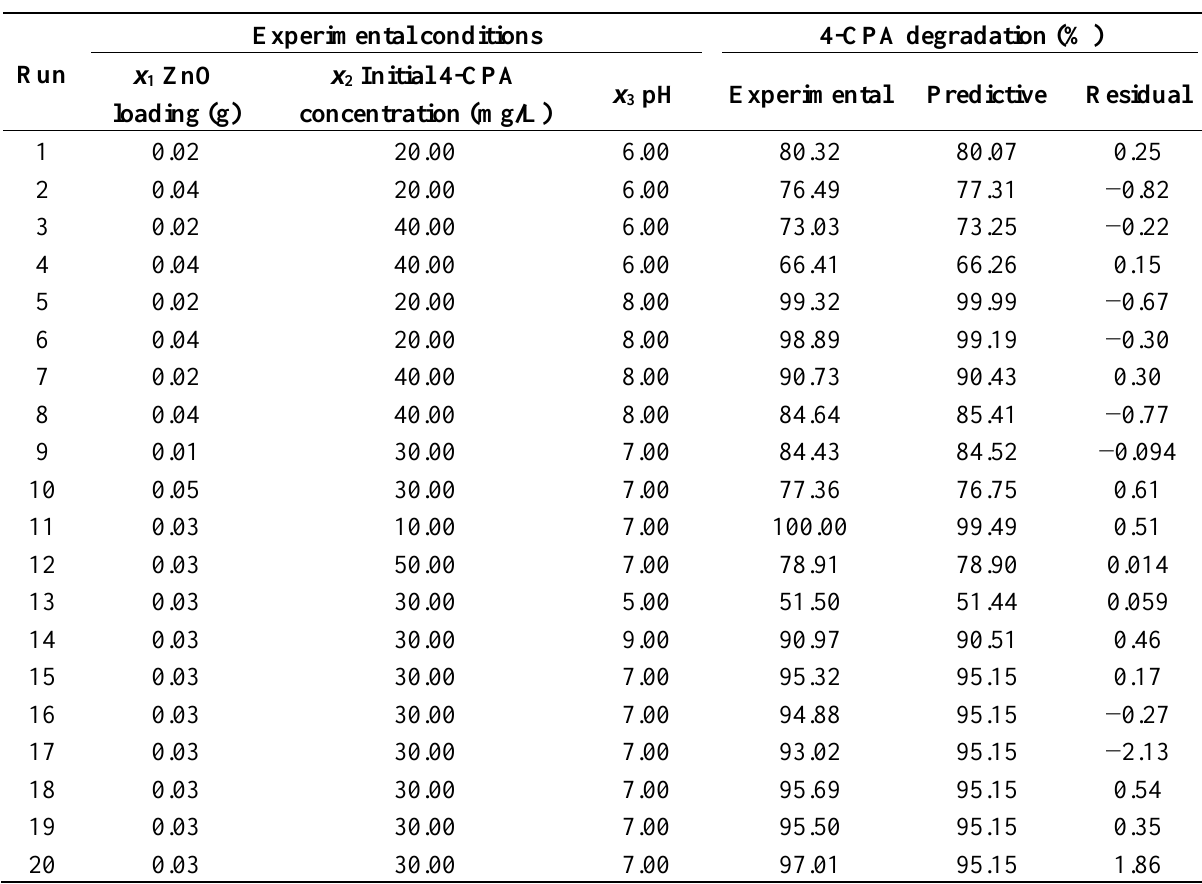
Table 2. Central composite design with predictive values and their experimental